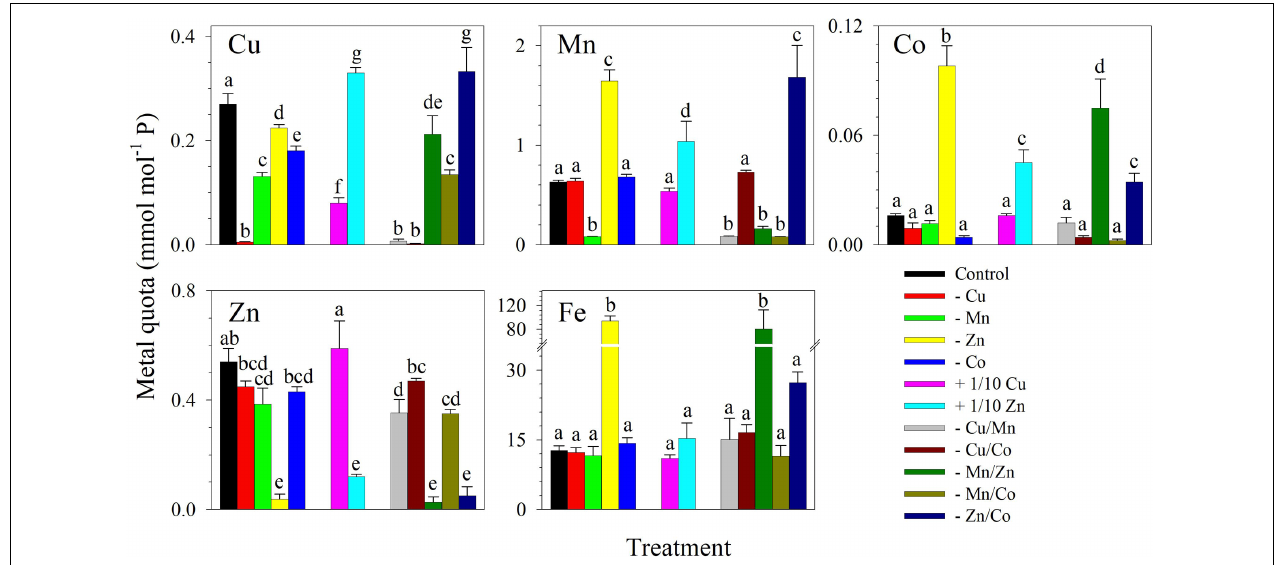
FIGURE 2 | Intracellular trace metal quotas of S. kawagutii subjected to different trace metal conditions to investigate the interactive effects of Cu, Zn, Mn, and Co. The control treatment was grown with 1.25 nM Fe (cid:48) , 125 pM Zn (cid:48) , 5 pM Cu (cid:48) , 4.2 nM Mn (cid:48) , and 20 pM Co (cid:48) . The values represent means ± SD ( N = 3, P < 0.05, ANOVA, post hoc Tukey